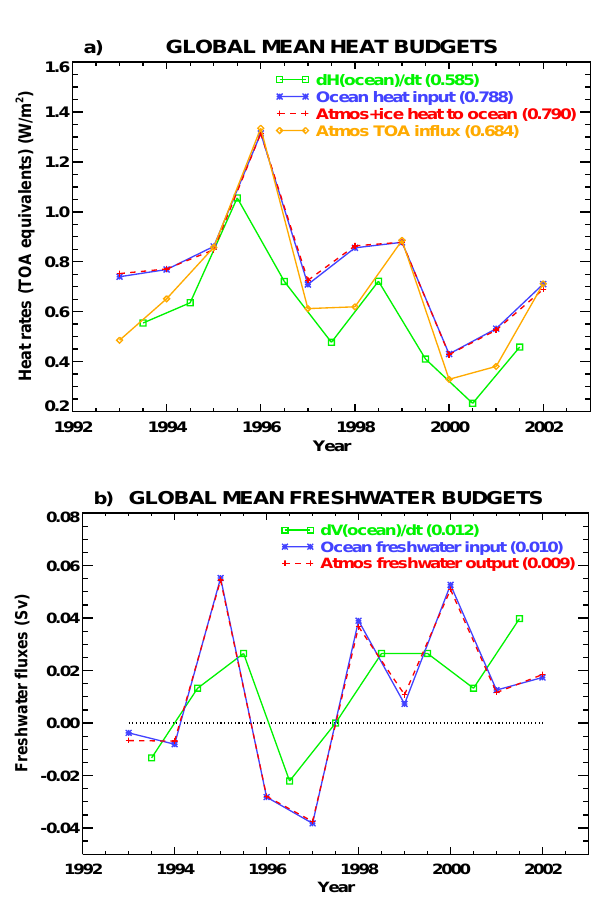
Fig. 6. Time series of global mean flux budgets. Overall time av- erages in parentheses. (a) Heat into ocean compared to heat leav- ing atmosphere and sea ice. Also shown are net top of atmosphere fluxes, and estimated rate of change of ocean heat content (from an- nual mean fields). (b) Freshwater into ocean and out of atmosphere, and estimated rate of change of ocean volume (from annual mean